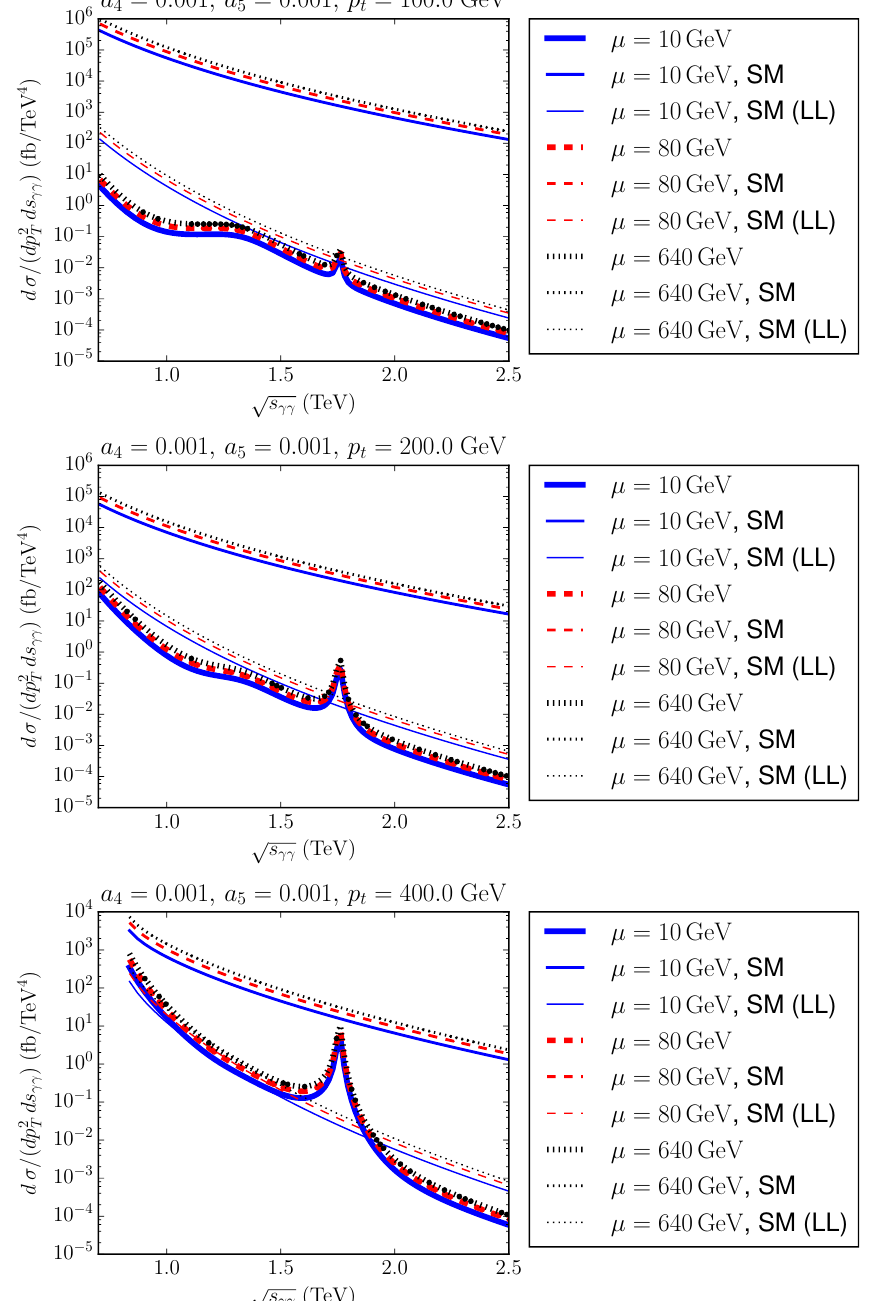
Figure 14 . Cross section for pp ground [82, 83]. From top to bottom, p T = 100 ; 200 ; 400 GeV; in each graph we show the scale dependence. The SM background only includes the WW signal, since (cid:13)(cid:13) SM(LL) stands for the SM background (cid:13)(cid:13)